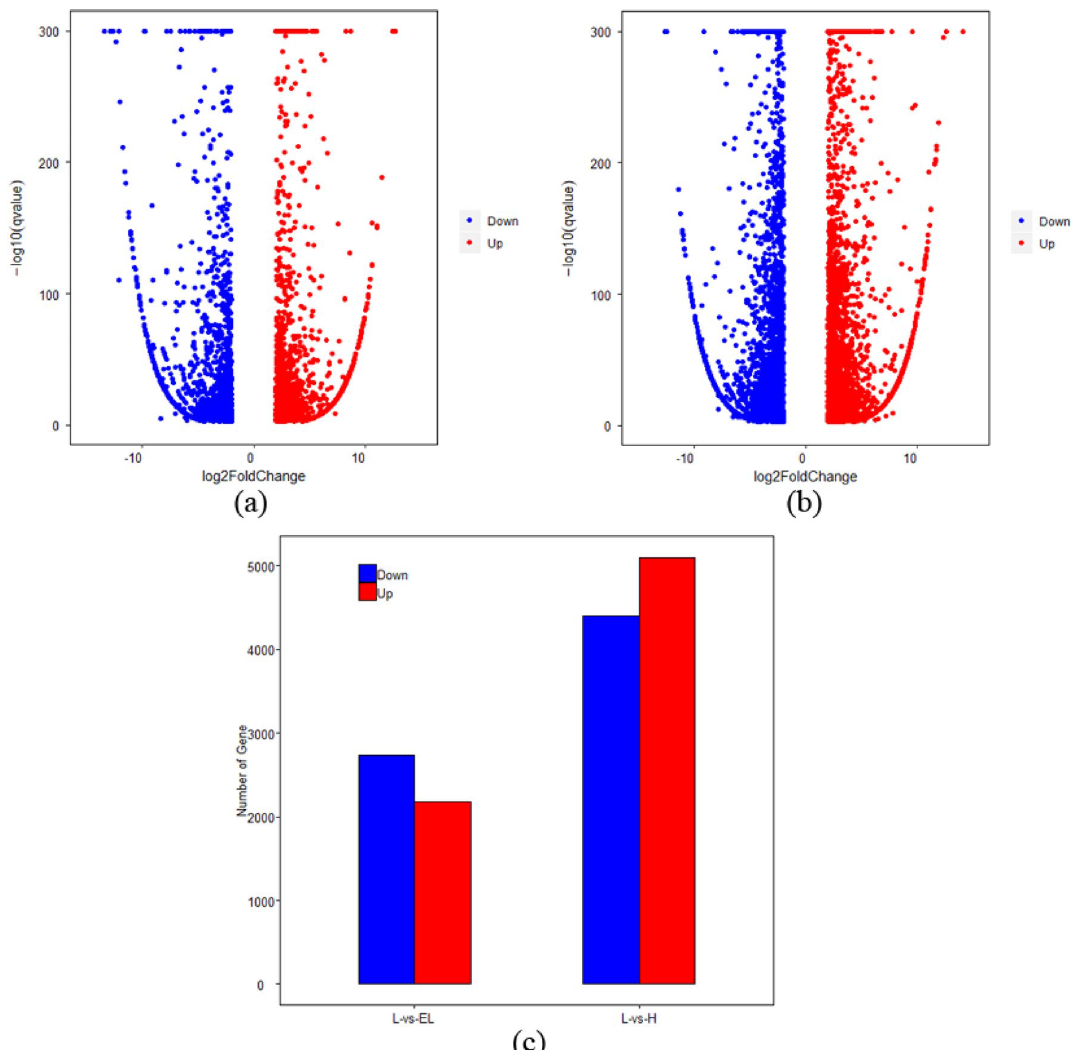
Figure 1. Volcano plots of DEGs in the roots of walnut seedlings under nitrogen starvation ( a ) and excess ( b ). Red dots indicate genes upregulated in the treatment group compared to control, and blue dots indicate genes downregulated in the treatment group relative to control. ( c ) Numbers of up- and downregulated genes under nitrogen starvation versus control (L-vs-EL) and under nitrogen excess versus control (L-vs-H). Red bar: number of upregulated genes; blue bar: number of downregulated